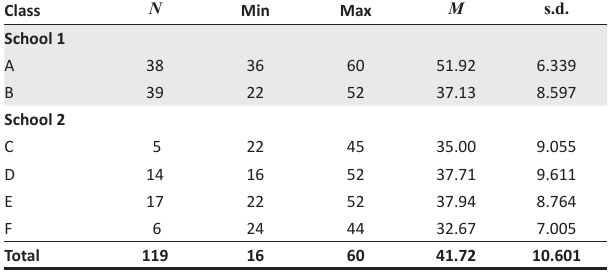
TABLE 2: Descriptive statistics for the total classroom climate scores by class.